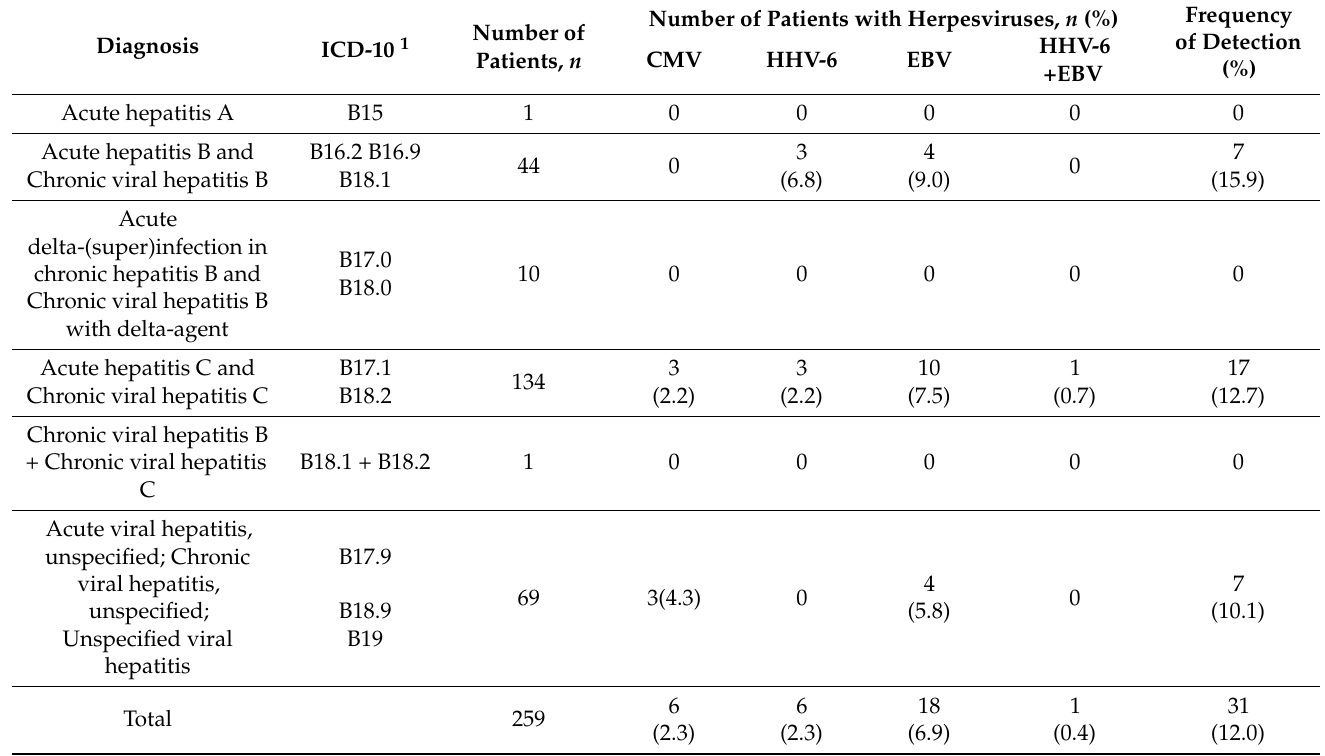
Table 1. The frequency of herpesviruses detection in the peripheral blood of patients with different etiologies of liver damage. Diagnosis ICD-10 1